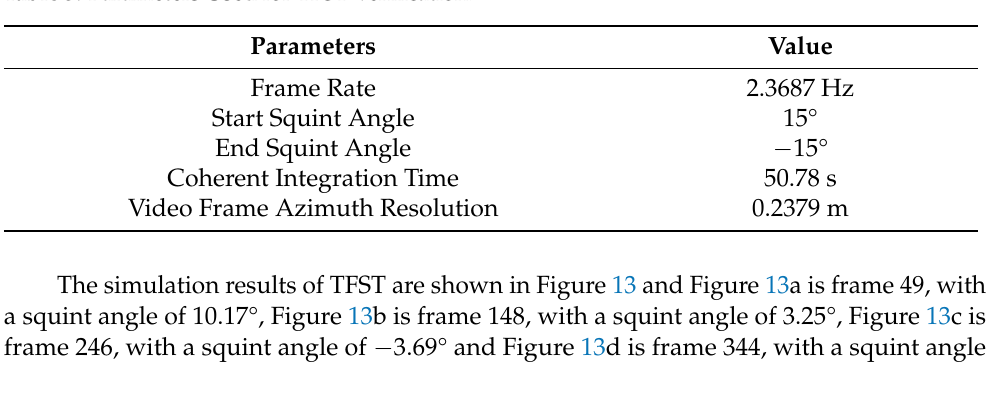
Table 3. Parameters Used for TFST